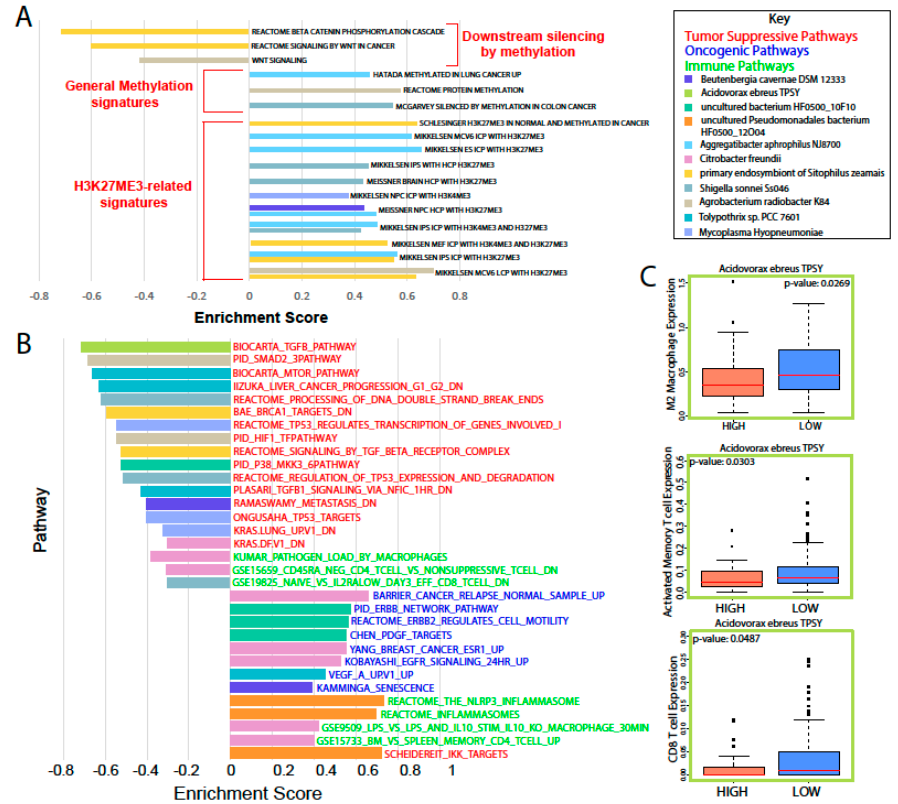
Figure 3. Analysis of cancer and immune-associated gene expression related to microbial abundance.